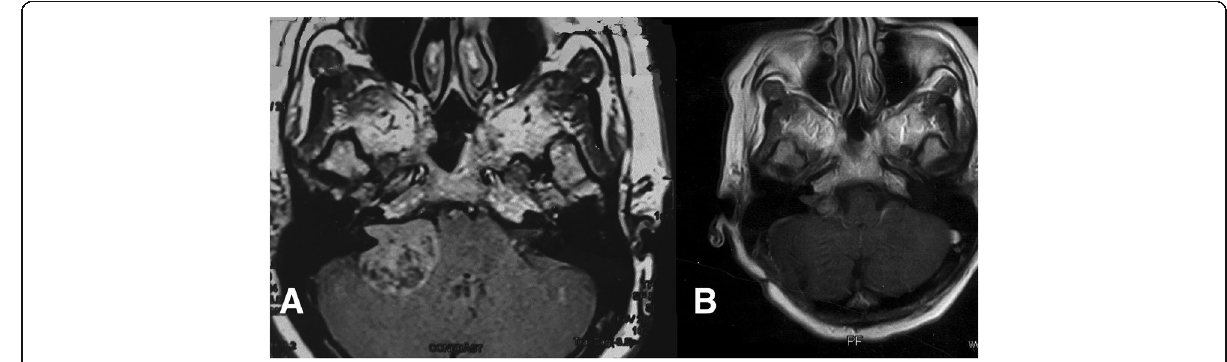
Fig. 4 a Axial T1 postcontrast MRI showing a vestibular schwannoma. b A 6-month postoperative postcontrast axial T1 MRI showing near-total resection and HB grade